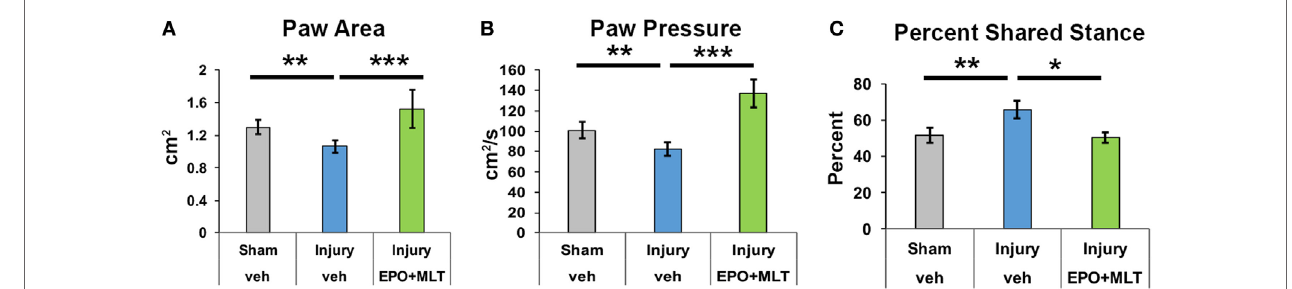
FigUre 2 | Prenatal injury impairs gait performance. (a) After prenatal injury, vehicle-treated rats contact their hindpaws with less area than sham or erythropoietin (EPO) + melatonin (MLT)-treated injured rats. (B) Similarly, vehicle-treated injured rats contact hindpaws with less pressure than shams or EPO + MLT-treated rats. (c) The percent of shared stance is elevated in vehicle-treated rats with prenatal injury compared to shams, and EPO + MLT treatment normalizes gait and posture (two-way ANOVA with Bonferroni correction, * p < 0.05, ** p < 0.01, *** p < 0.001).